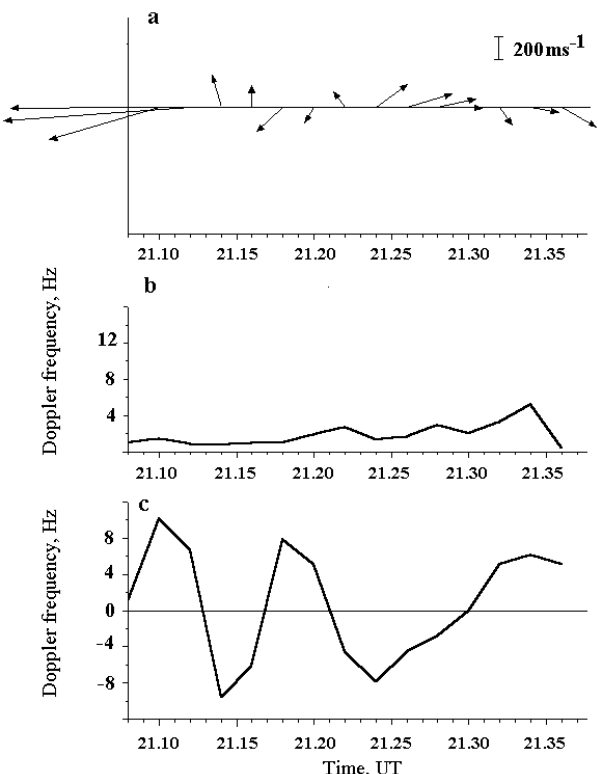
Fig. 7. Simulation results of Doppler frequency shifts on the Lon- don – Tromsø – St.Petersburg path at 9410kHz for the geophys- ical conditions on 16 February 1996, taking into account the real ionospheric data from EISCAT UHF radar measurements with 2- min temporal resolution: (a) plasma velocity vectors from EISCAT UHF radar measurements during the HF pumping experiment on 16 February 1996; (b) Doppler frequency shifts versus time, tak- ing into account only electron density changes in the scattering vol- ume; (c) Doppler frequency shifts versus time, taking into account the plasma velocities given in panel “a”, as well as electron density changes in the scattering volume.